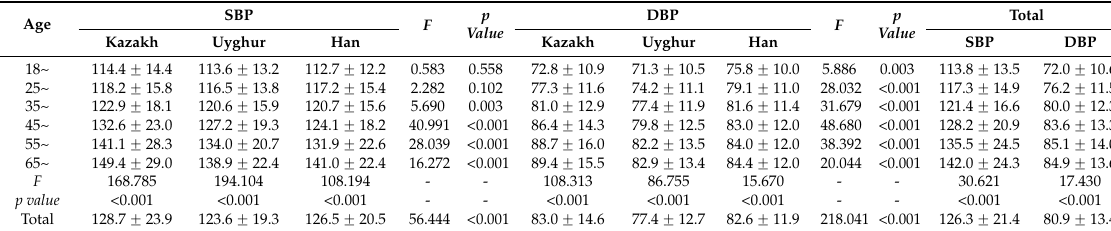
Table 2. Level of blood pressure by age and nationality.